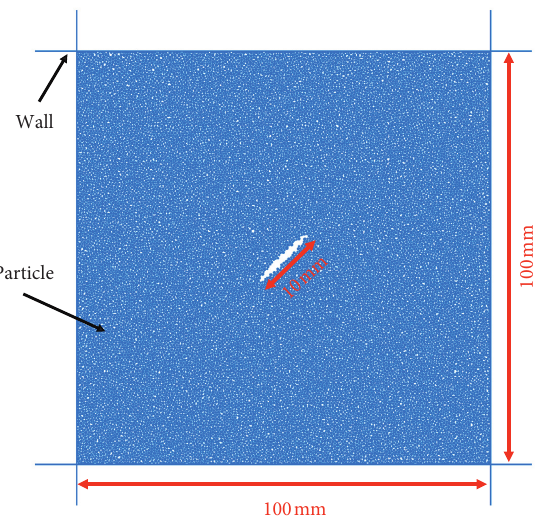
Figure 2: Schematic of a numerical model with prefabricated el- liptical crack.